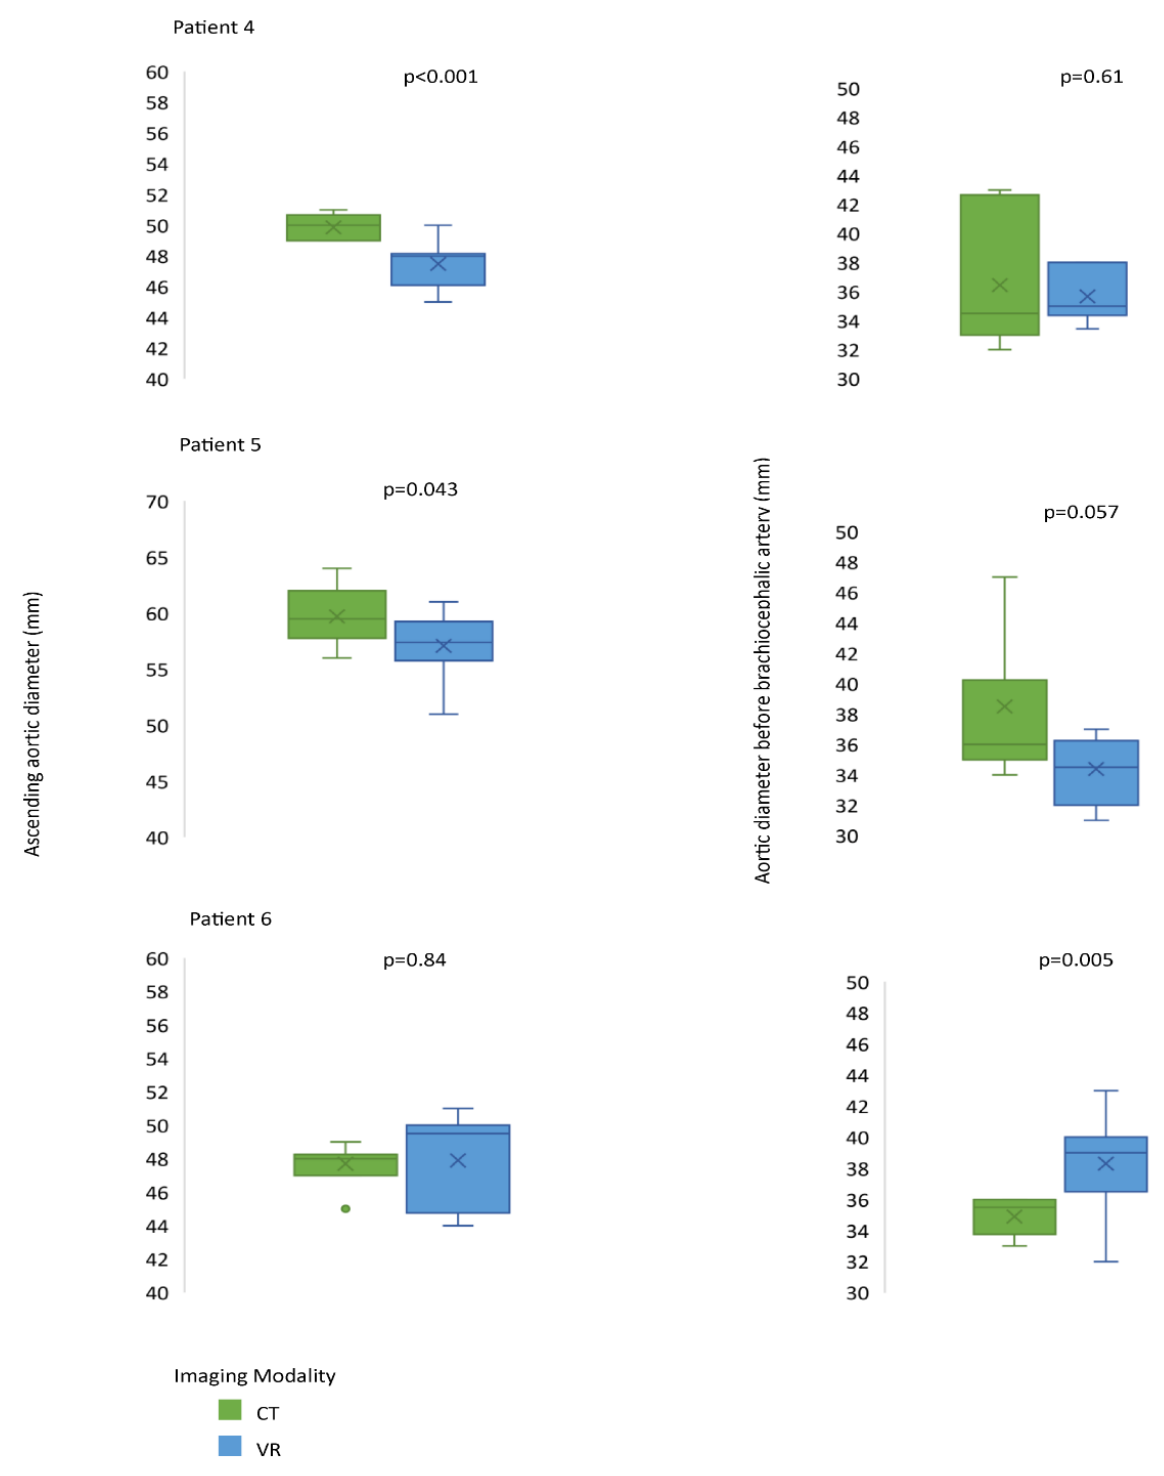
Figure 3. Measurements of maximal ascending aortic diameters and aortic diameters proximal to the brachiocephalic artery. Table 1. Overall preference (n = 10) for clamped versus open distal ascending aortic anastomosis per patient based on computed tomography or virtual reality.